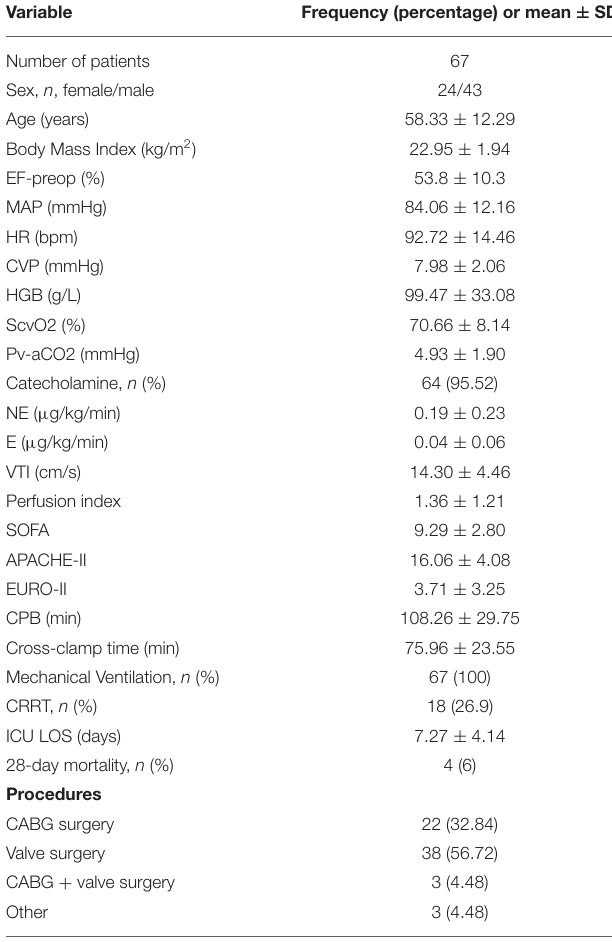
TABLE 1 | Characteristics of